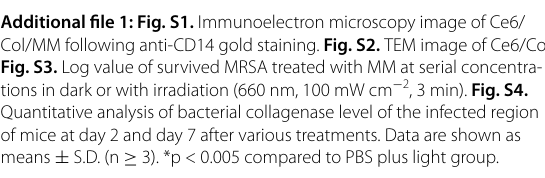
Fig. S3. Log value of survived MRSA treated with MM at serial concentra- tions in dark or with irradiation (660 nm, 100 mW cm − 2 , 3 min). Fig. S4. Quantitative analysis of bacterial collagenase level of the infected region of mice at day 2 and day 7 after various treatments. Data are shown